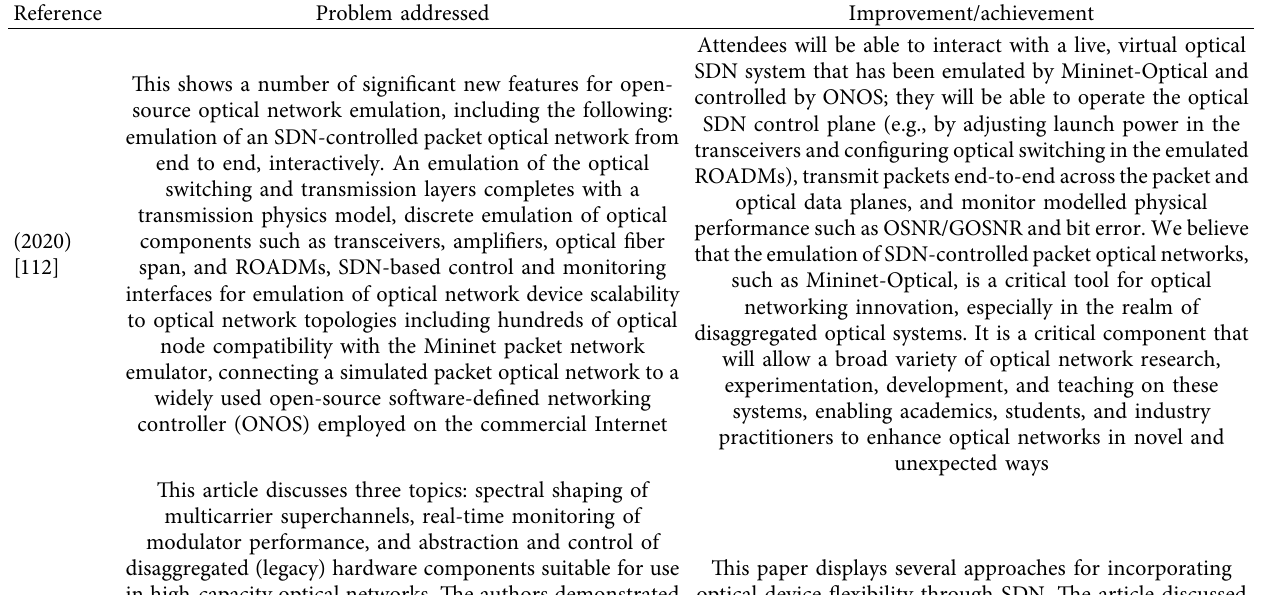
Table 8: Summary of work done in SDON